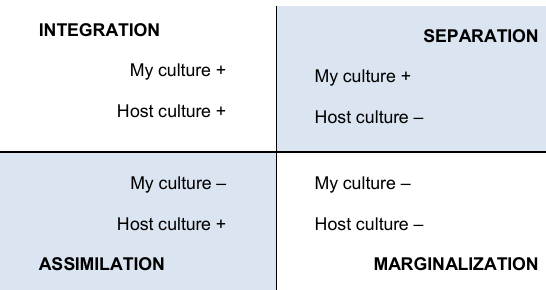
Figure 1: Scheme of the fourfold taxonomy of acculturation styles. Positive and negative attitudes concerning the Native culture and the Host culture